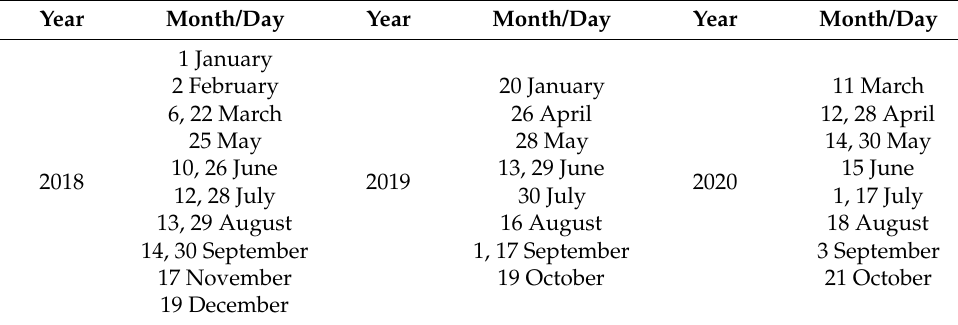
Table 2. Landsat 8 images dates extracted in the GEE